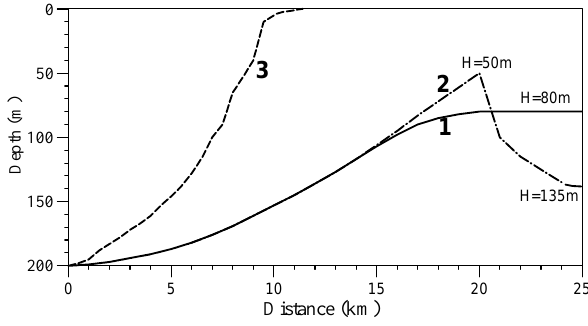
Fig. 2. Bottom profiles used in the model. Numbers 1–3 correspond to cross sections 1–3 in Fig.